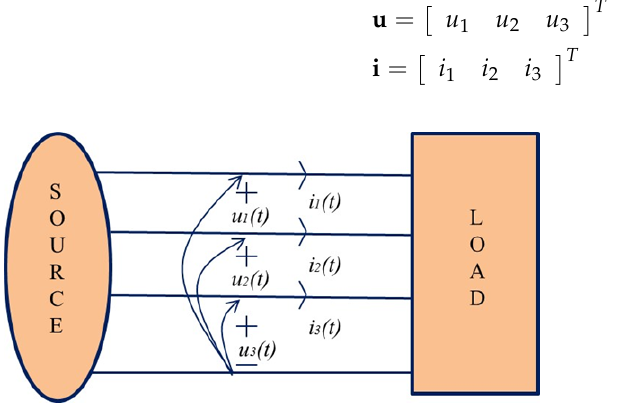
Figure 1. Phase-neutral voltages and line currents in a three-phase power system.